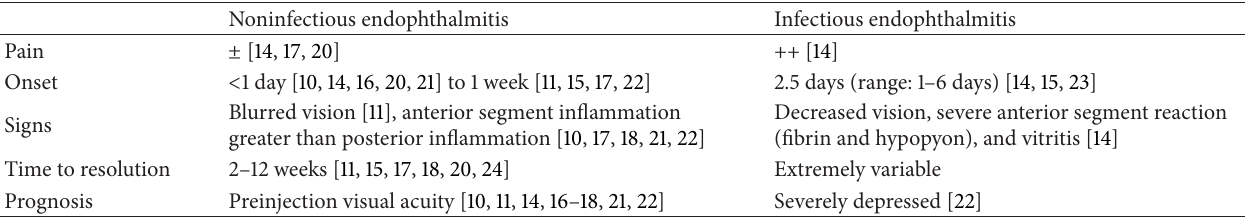
Table 1: Clinical characteristics of noninfectious versus infectious endophthalmitis.